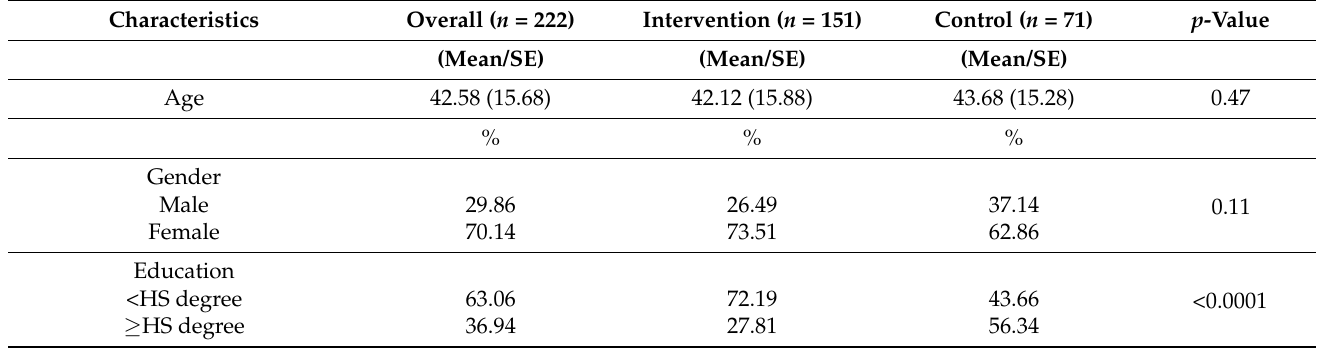
Table 1. Baseline characteristics ( N =